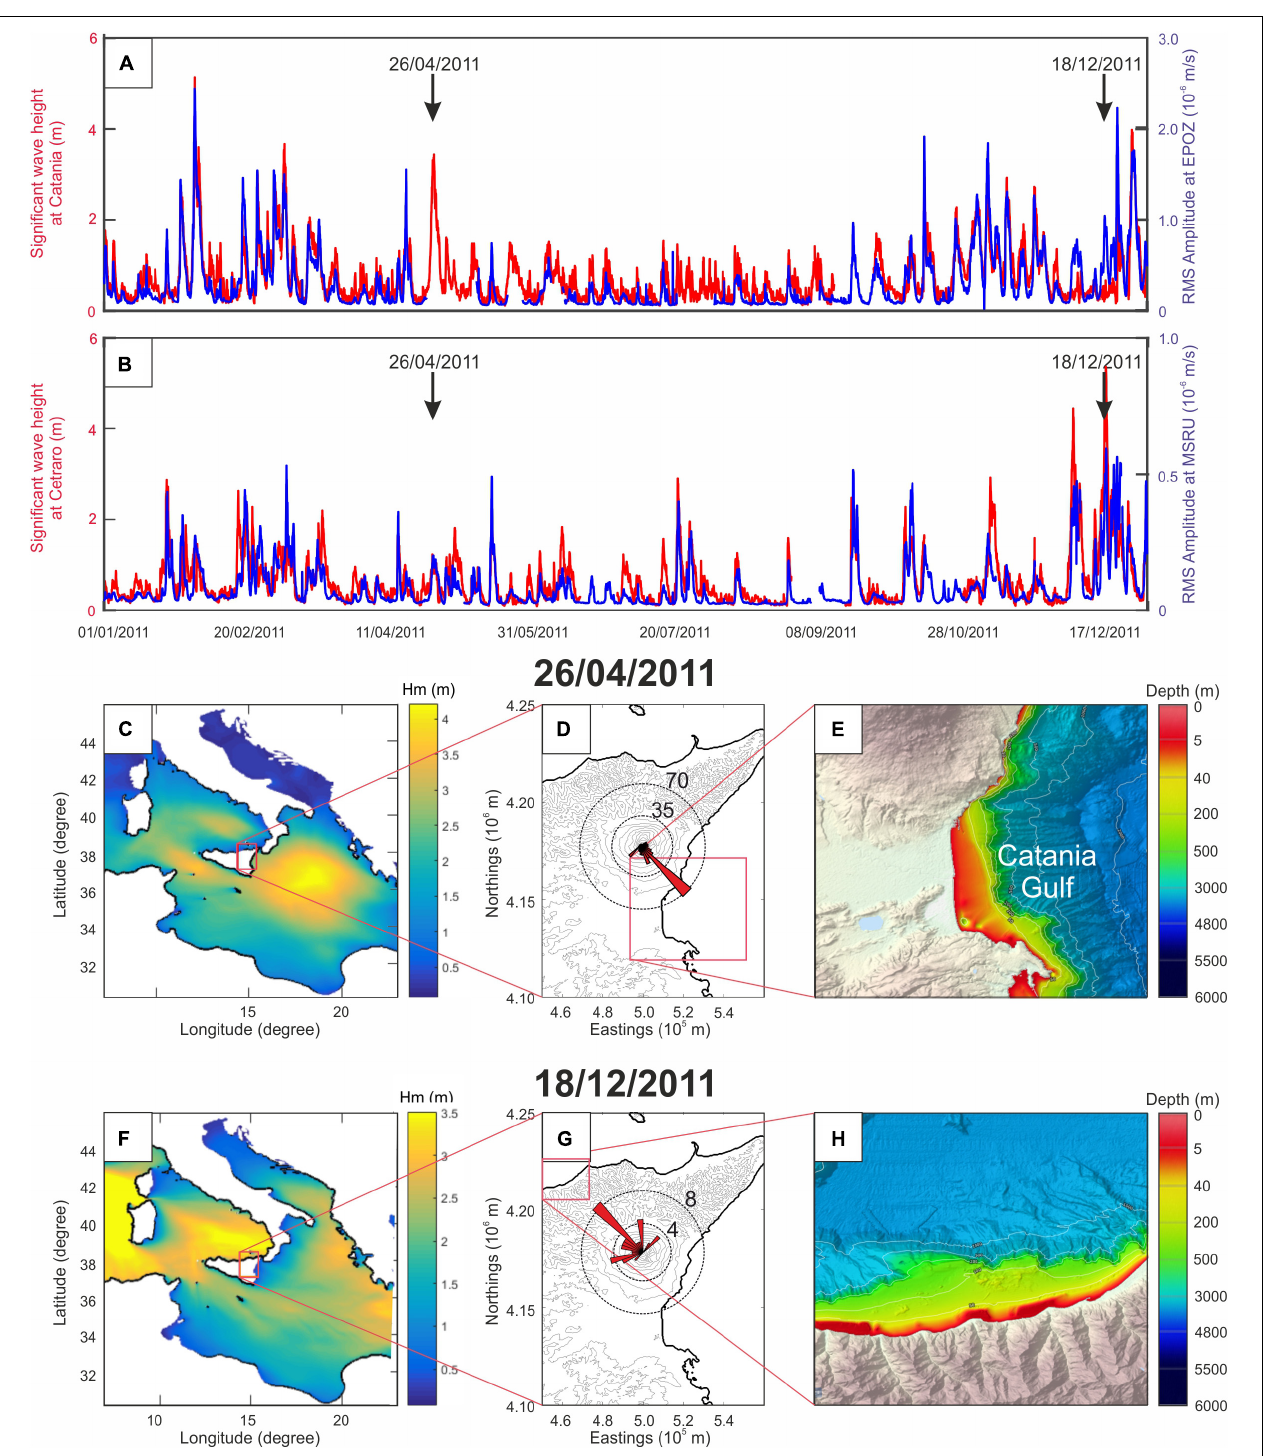
FIGURE 7 | (A,B) Time series of significant sea wave height recorded by the Catania and Cetraro buoys ( red lines ) and the RMS amplitude computed in the period band 2.5–5.0 s (SPSM) by EPOZ and MSRU stations ( blue lines ) in 2011. (C,F) Maps of a portion of the Mediterranean Sea showing the spatial distribution of the significant wave height on 26/04/2011 at 12:00 and on 18/12/2011 at 12:00, respectively (MEDSEA_HINDCAST_WAV_006_012 product from http://marine.copernicus.eu/services-portfolio/access-to-products/). (D,G) Digital elevation models of Eastern Sicily with rose diagrams, located at the center of the seismic summit ring of Mt. Etna (see Figure 1b ), showing the distribution of the back azimuth values on 26/04/2011 and 18/12/2011, computed by f – k analysis. (E,H) Maps showing the bathymetry of portions of Sicily coastlines (EMODnet Bathymetry Consortium, 2018).